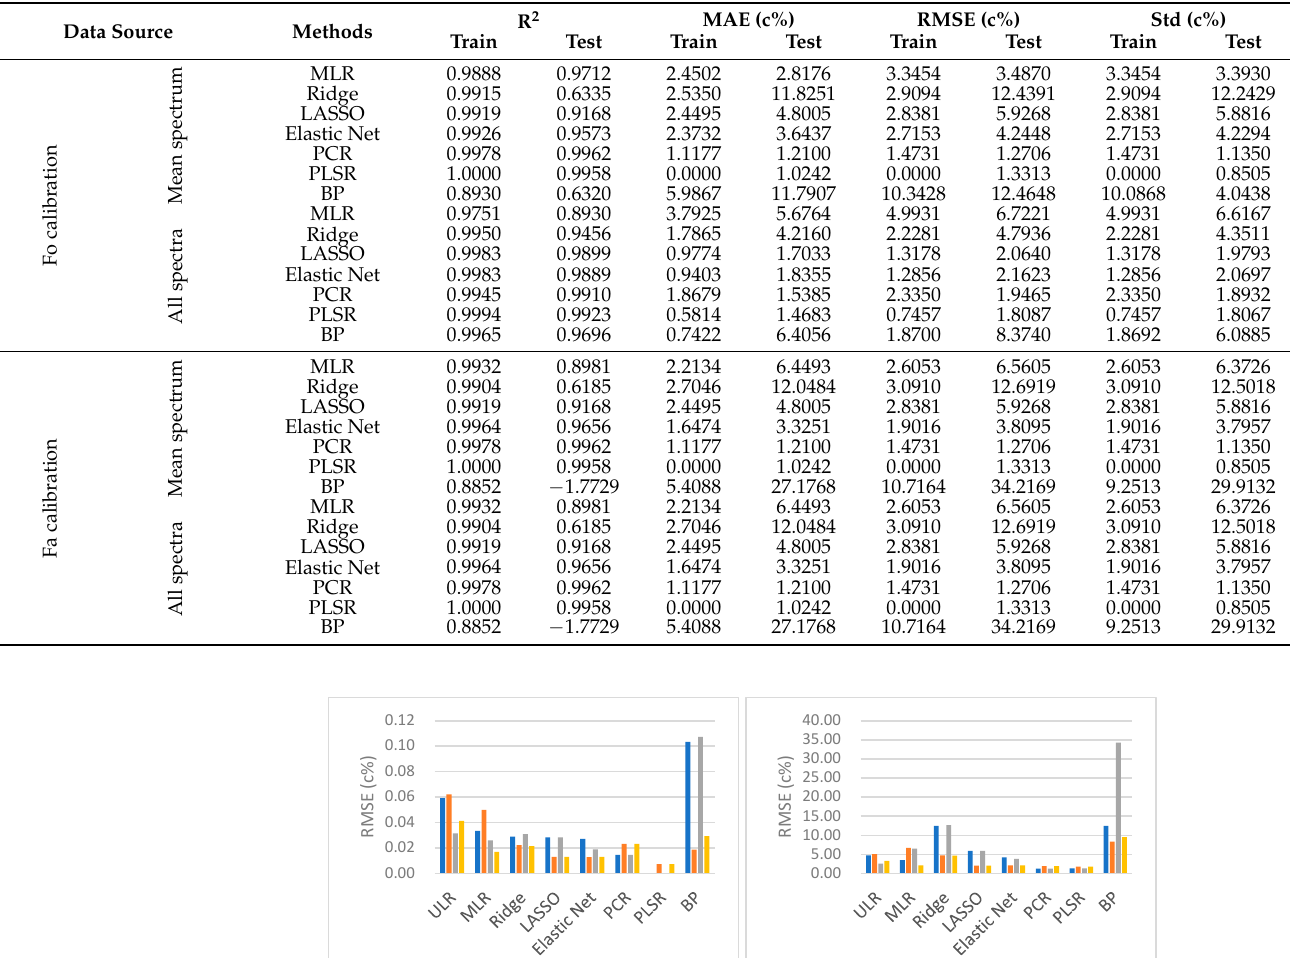
Table 4. Accuracy of quantitative analysis for Fo and Fa with MLR, ridge, LASSO, elastic net, PCR, PLSR, and BP.